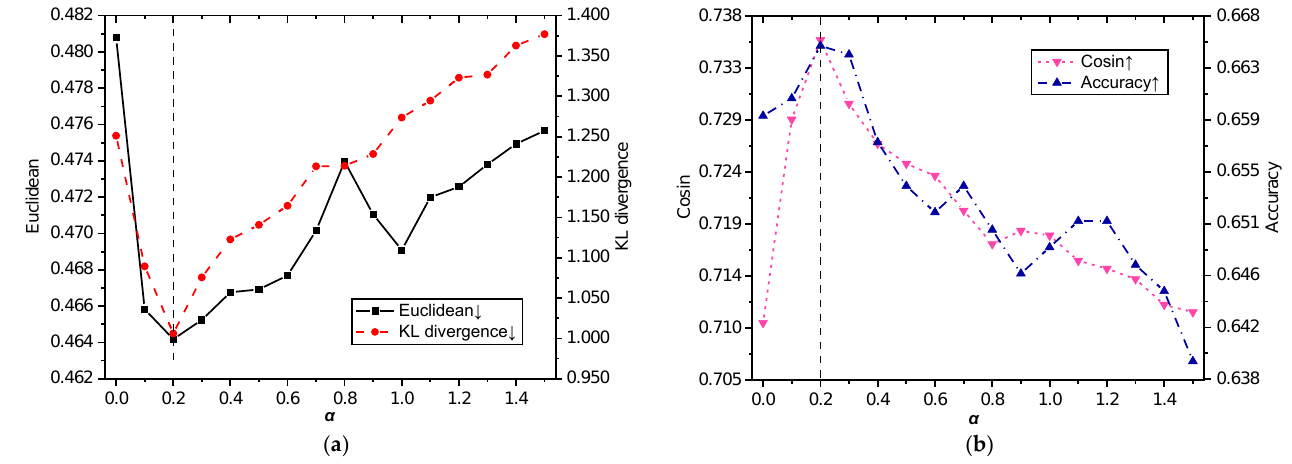
Figure 4. The Influence of the weight coefficient α on the performances of the LMT-CNN model on the Ren-CECps dataset ( ↑ means that the larger the indicator is, the better, and ↓ means that the smaller the indicator is, the better). ( a ) Euclidean and KL Divergence ; ( b ) Cosine and Accuracy .